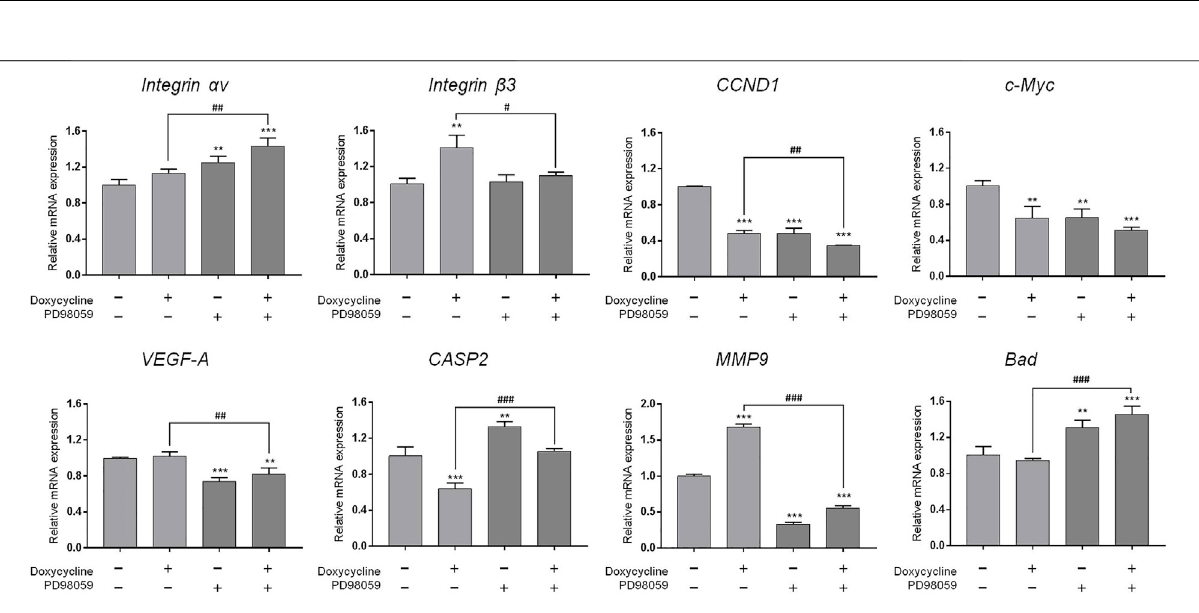
Frontiers in Cell and Developmental Biology |